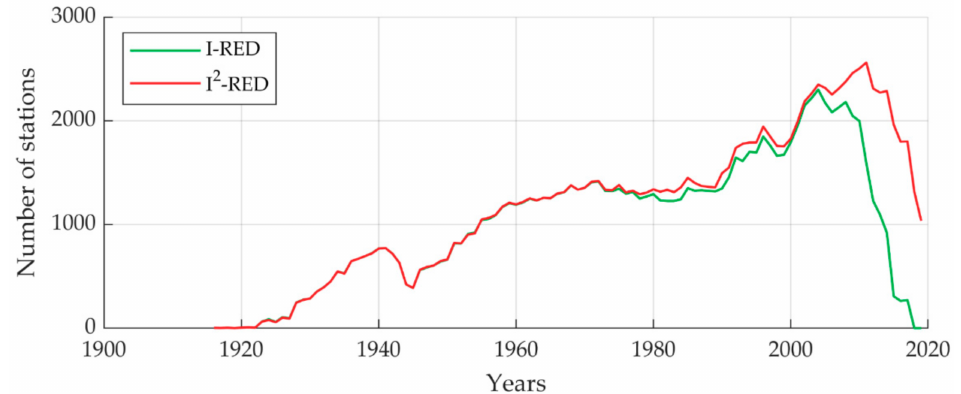
Figure 3. Number of stations included in the two I-RED databases year by year. The green line refers to I-RED, while the red line refers to I 2